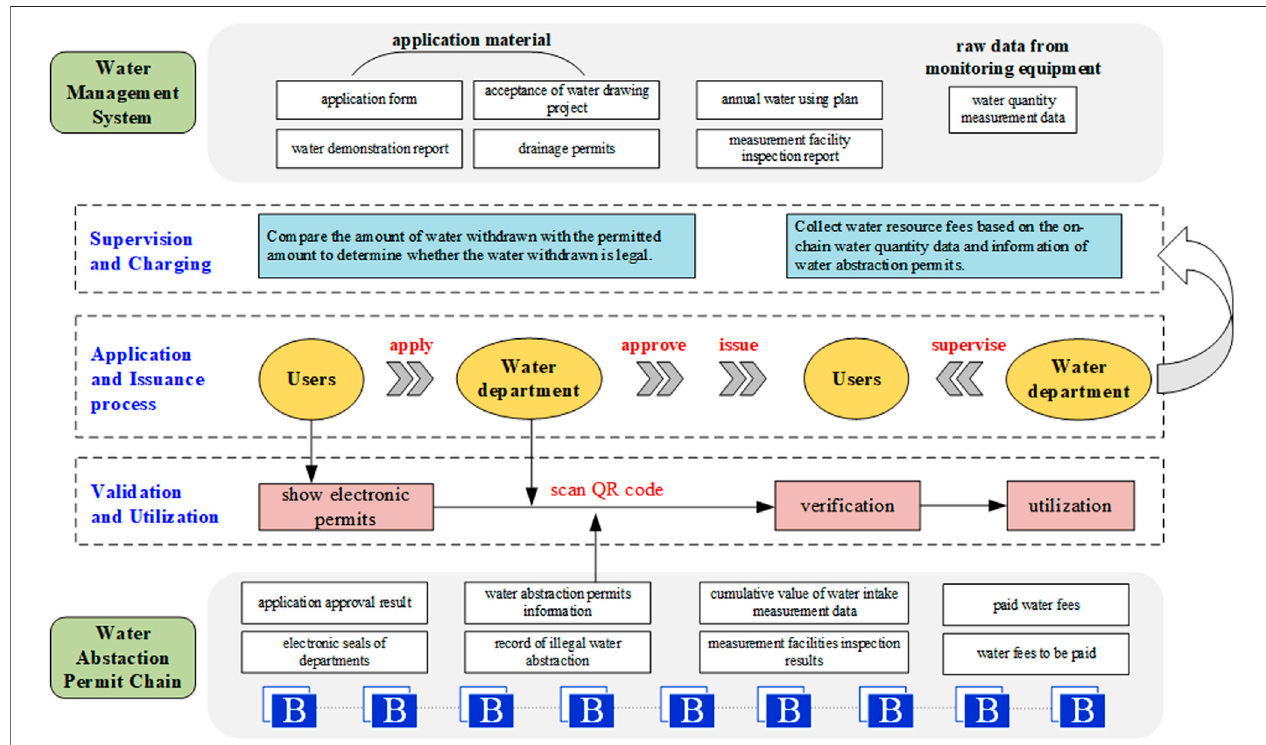
FIGURE 4 | The application scenario of blockchain-based information veri fi cation when electronic water abstraction permits is being used.